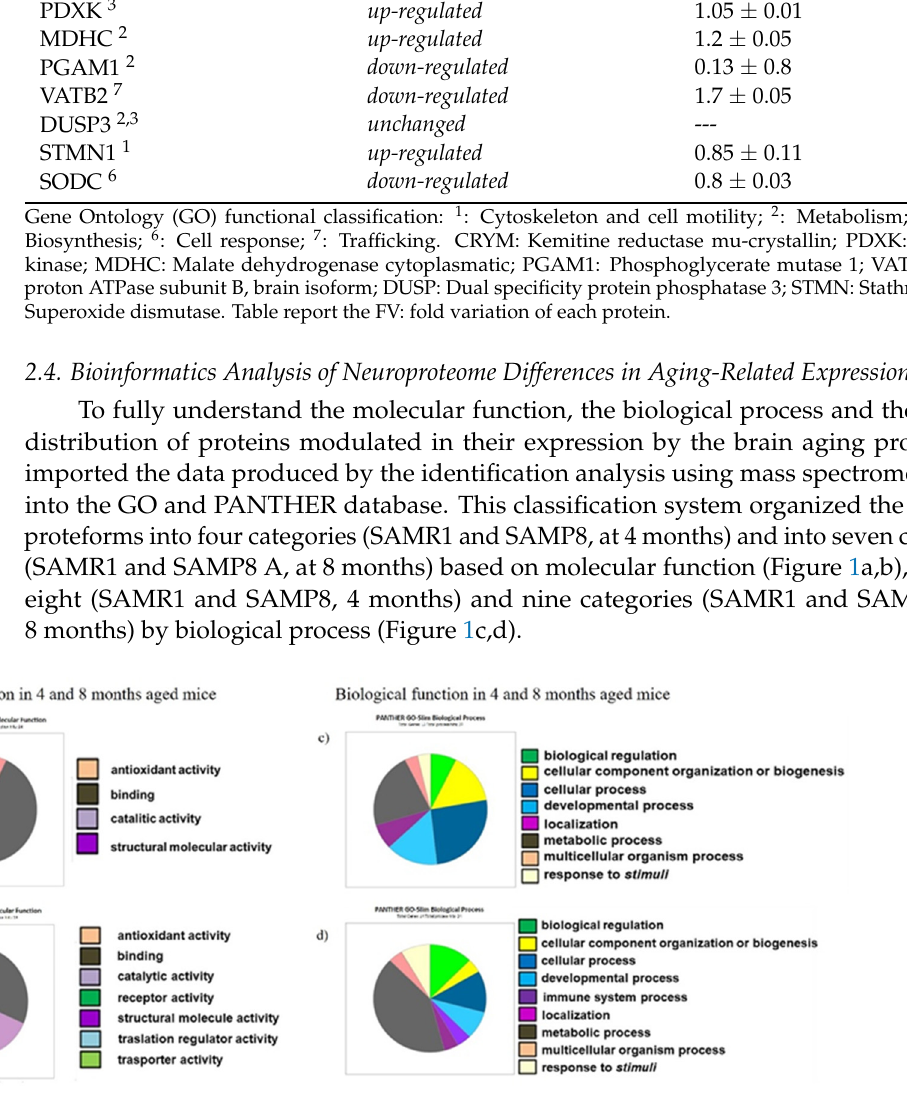
Figure 1. PANTHER classification by Gene Ontology of the common and specific proteins in SAMP8 and SAMR1 at 4 and 8 months; ( a ) molecular function distribution in 4-month-aged mice; ( b ) molecular function distribution in 8-month-aged mice; ( c ) biological process classification in 4-month-aged mice; ( d ) biological process classification in 8-month-aged mice.